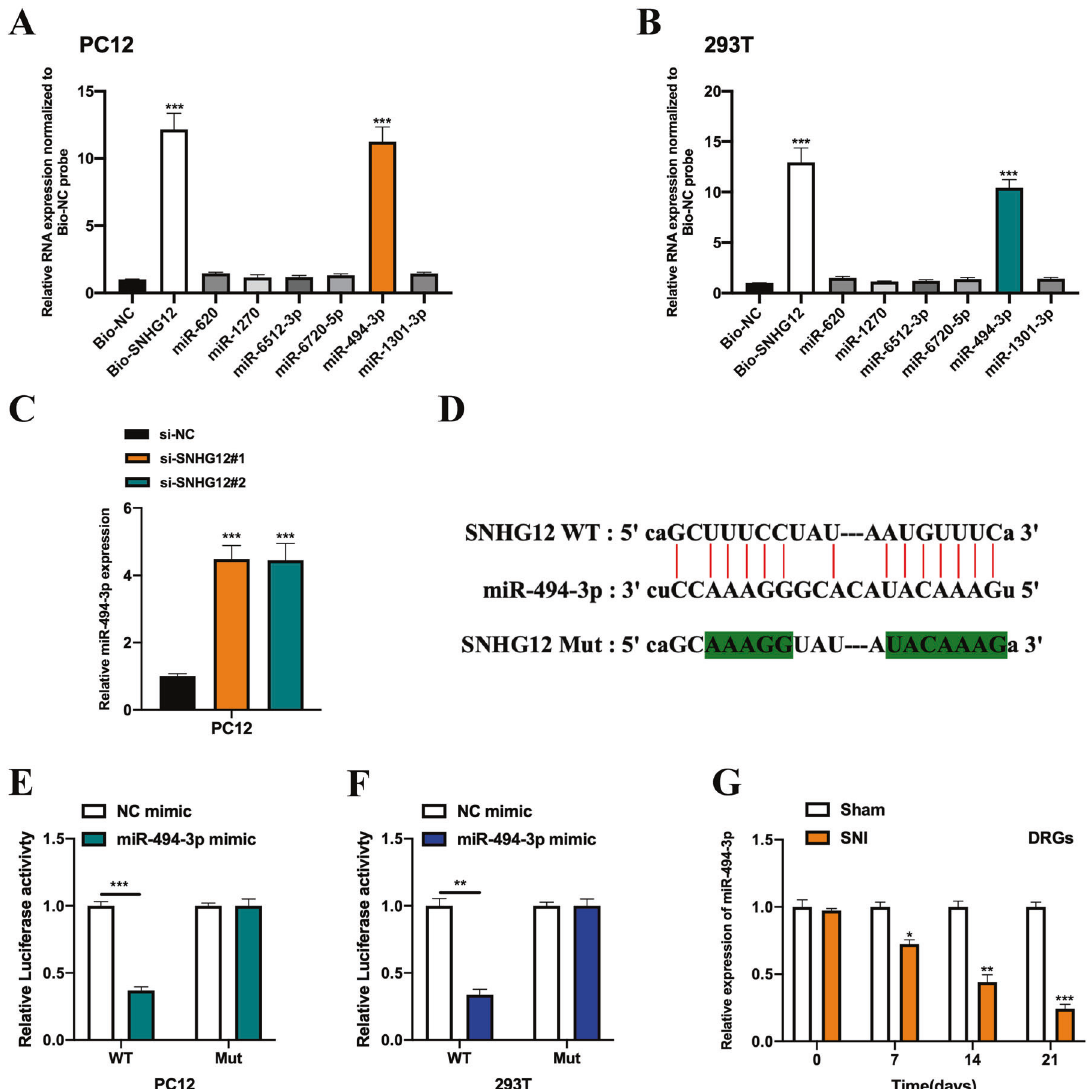
Fig. 4 MiR-494-3p is a molecular sponge for lncRNA SNHG12. Biotinylated RNA pull-down assay followed by qRT-PCR assay was performed to assess relative expression levels of putative miRNA targets of lncRNA SNHG12 in PC12 cells ( A ) and 293 T cells ( B ). C The relative expression level of miR-494-3p in lncRNA SNHG12 downregulated PC12 cells was measured by qRT-PCR. D Predicted binding sequences between lncRNA SNHG12 and miR-494-3p are shown. The binding possibility between lncRNA SNHG12 and miR-494-3p was veri fi ed by a luciferase reporter gene assay in PC12 cell ( E ) and 293 T cell ( F ). G The relative expression level of miR-494-3p in the DRGs of rats from the Sham or SNI groups was measured by qRT-PCR. Experimental data are presented as mean ± SD. * P < 0.05, ** P < 0.01, *** P <